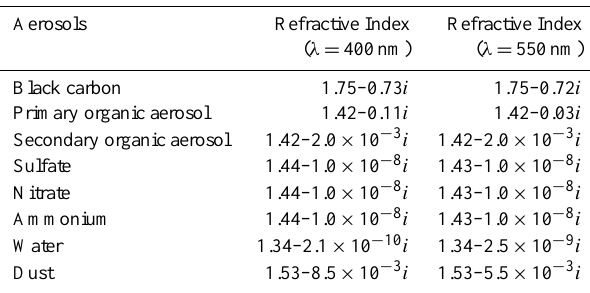
Table 1. Aerosol optical constants used in the calculation of aerosol optical properties.